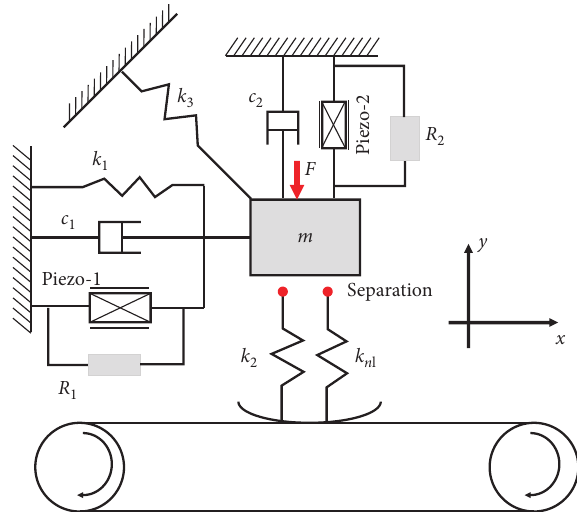
Figure 17: The situation that mass separates from the sliding